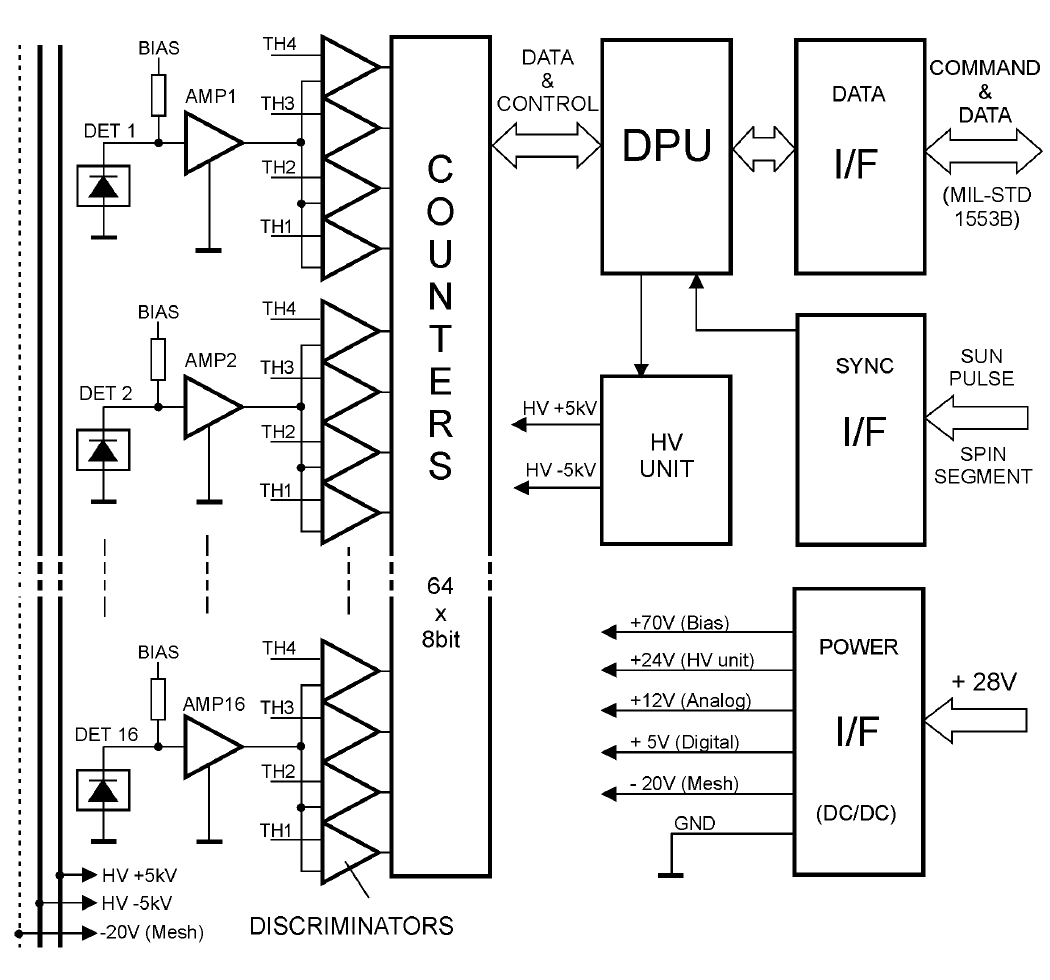
Fig. 11. Simplified functional block diagram of the NUADU